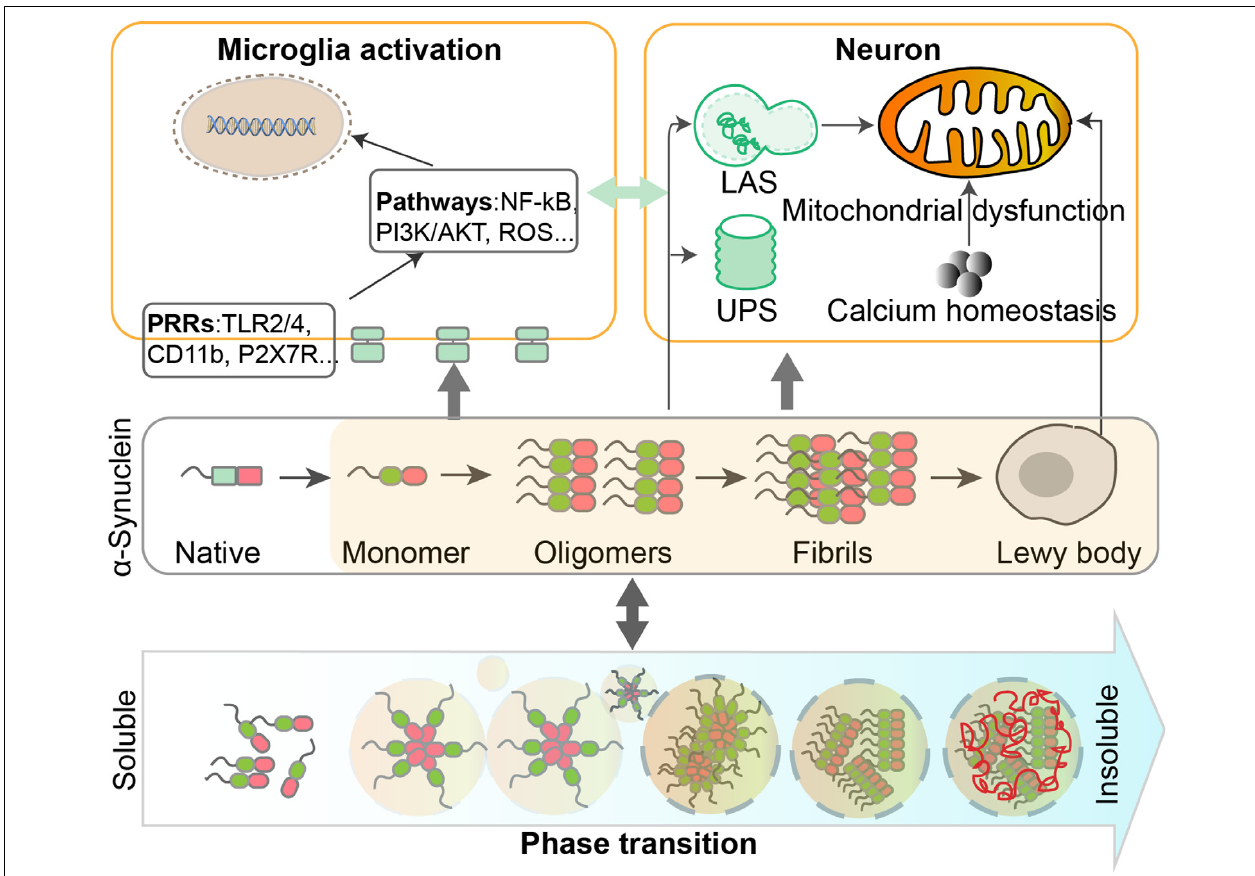
FIGURE 1 | Dynamic regulation and phase transition of α -Synuclein are involved in the pathogenesis of Parkinson’s disease (PD). α -Synuclein consists of three domains and can undergo post-translational modifications (PTMs) such as phosphorylation, SUMOylation, nitration, and O-GlcNAcylation. The transition of α -Synuclein from a monomeric to oligomeric state and further to fibrils is related to the pathological gain of toxicity in PD. Intracellular homeostasis of α -Synuclein is maintained under the surveillance of the ubiquitin-proteasome system (UPS) and lysosomal autophagy system (LAS). Accumulation of α -Synuclein will take place when these degradation systems are damaged. α -Synuclein aggregates could impair mitochondrial functions in human dopaminergic neurons, by altering calcium homeostasis. Different forms of α -Synuclein could activate microglia through different receptors and downstream pathways, leading to inflammatory responses that contribute to